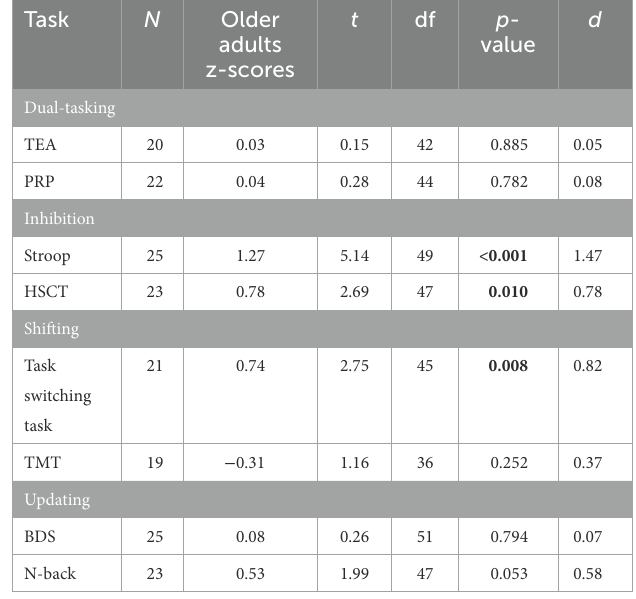
The table contains the independent t -tests of the average outcome measures (z-scores) for all eight tasks between young and older